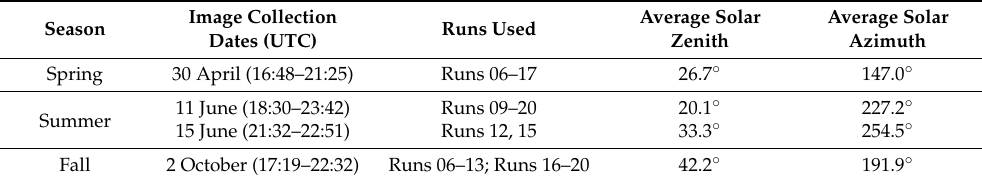
Table 1. Summary of San Francisco Bay Area AVIRIS-C images for the year 2015.